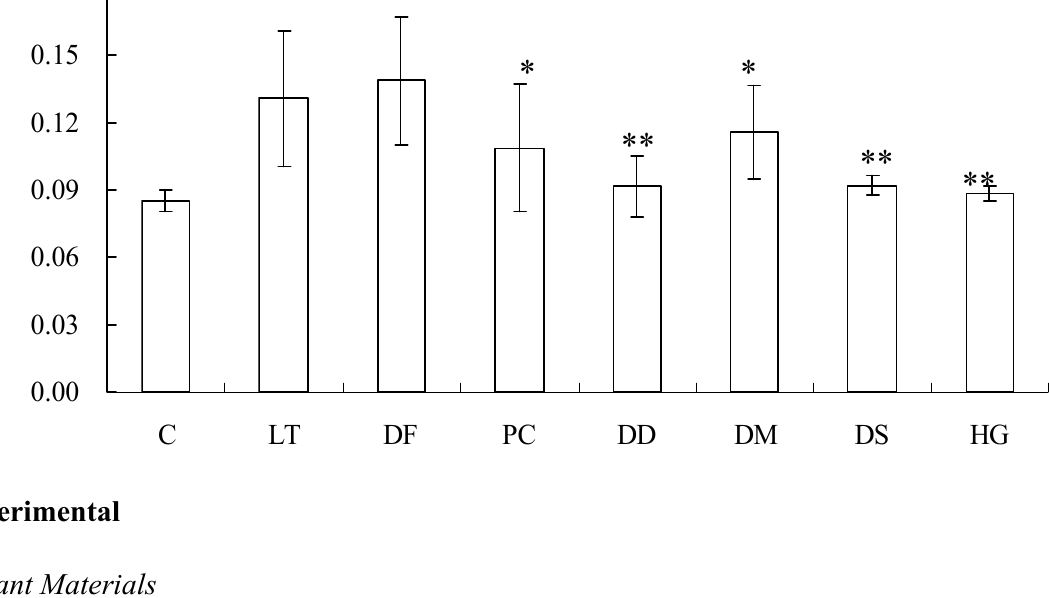
Figure 2. Anti-diarrheal effect of six sources of Gusuibu by patent mouse gut assay. Three mice per group were administrated orally with PBS, 10 μ g LT, or in conjunction with different sources of Gusuibu. After 6 h incubation, mice were sacrificed. The gut/carcass weight ratio was calculated for each group. Values represent mean ± standard error of triplicate assays. C: control. * p < 0.05, ** p < 0.01 compared with